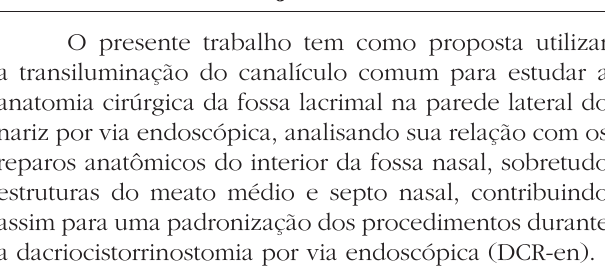
Etapa 2 - Introdução do feixe de fibra